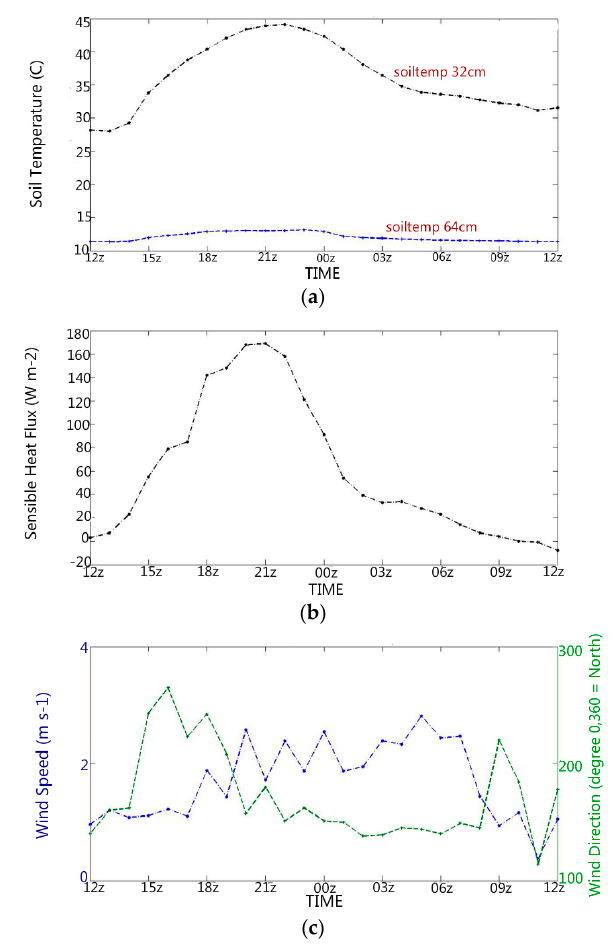
Figure 10. ( a ) ATDD Flux Site C observed 24 h diurnal variation of soil temperature (unit in °C) at 32 cm and 64 cm in OKC; ( b ) ATDD Flux Site C observed 24 h diurnal variation of sensible heat flux (W/m 2 ) in OKC; ( c ) ATDD Flux Site C observed 24 h diurnal variation of wind speed (unit in m/s) and wind direction in OKC.